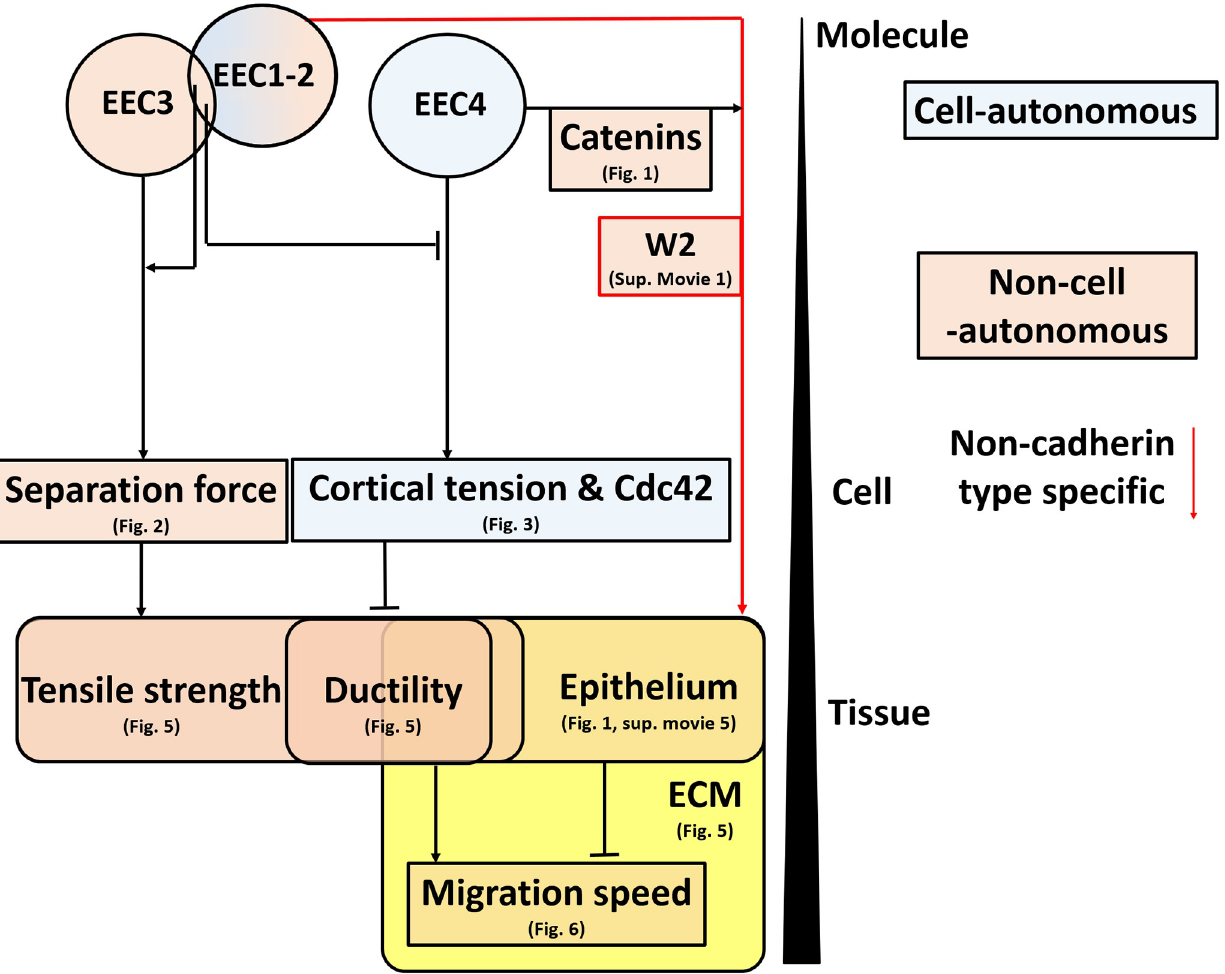
Fig 7. Proposed model depicting the influence of EEC1-4 domains on cell-autonomous and non-cell-autonomous cell and tissue properties. EEC4 regulates catenin recruitment and formation of epithelia on the extracellular matrix, and, antagonistically with EEC1,2 but in a Cdc42-dependent manner, cell–autonomous cortical tension. EEC1,2 also with EEC3 regulate intercellular separation forces together with the cytoskeleton and other cytoplasmic factors. High intercellular separation forces support tissue tensile strength while low cortical tension promotes tissue ductility. Tissue ductility in turn stimulates collective cell migration